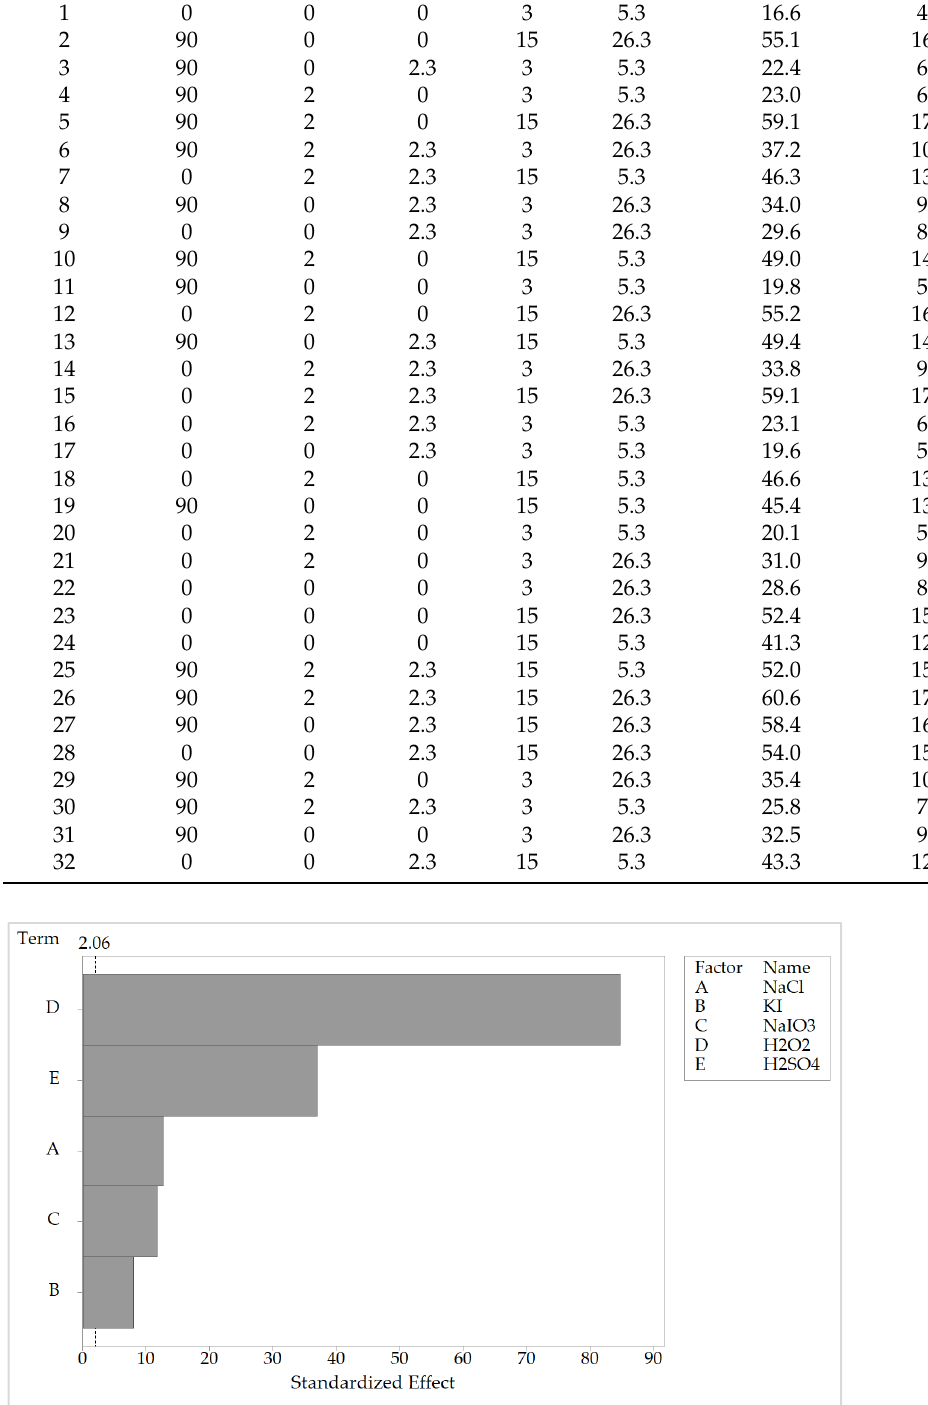
Figure 2. Pareto chart of effects.